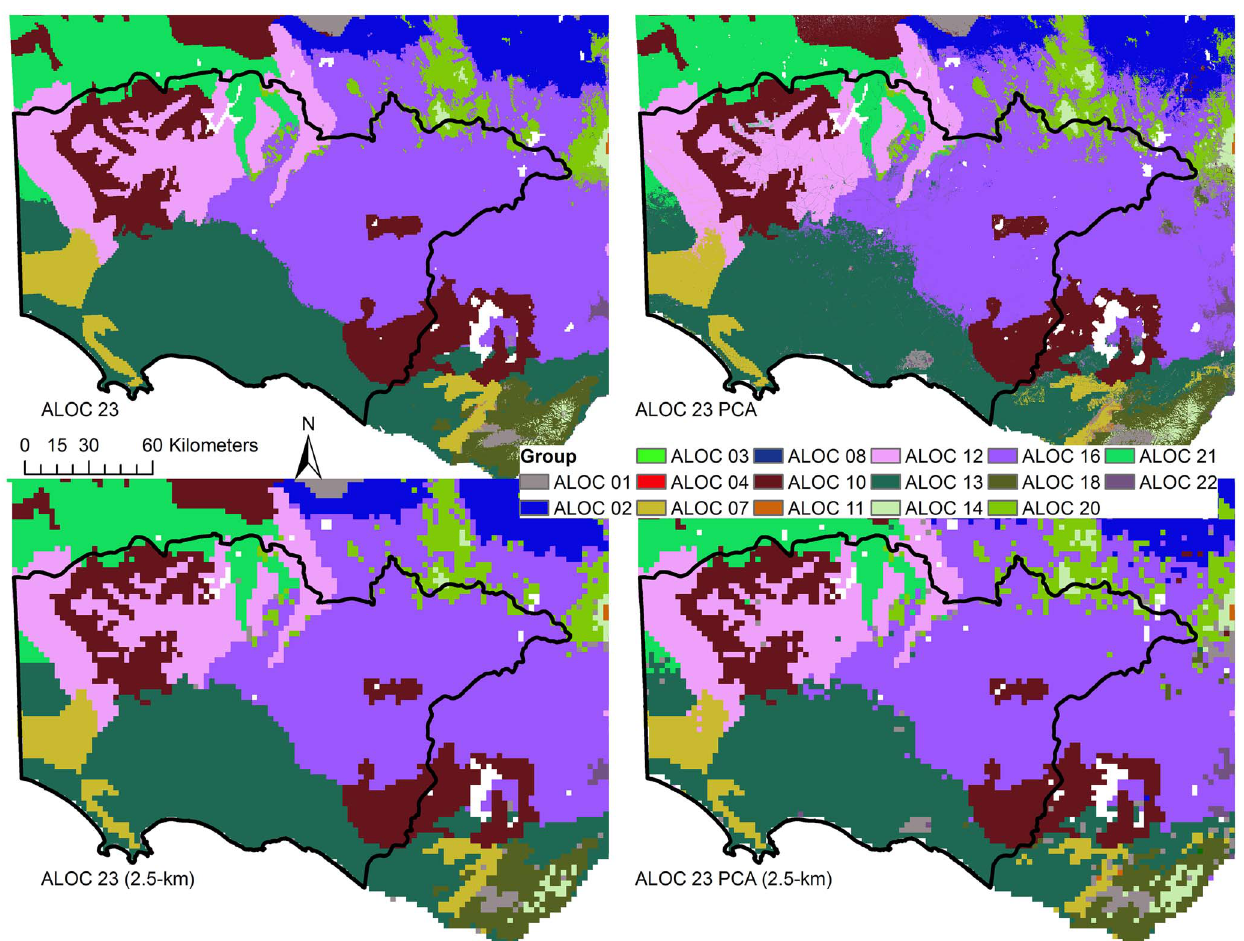
Figure 9. Results of the ALOC 23 (30 m) classifications for the Glenelg Hopkins region. Top row - ALOC 23 and ALOC 23 PCA; Bottom row - ALOC 23 and ALOC 23 PCA resampled to 2.5 km. Colours represent each of the ALOC non-hierarchical clusters. Similar colours and cluster numbers do not necessarily represent related groups. More spatial variability in the ALOC clusters is obvious in the Glenelg catchment (western and NW side), than that in the Hopkins (eastern) and Portland (south central) catchments.